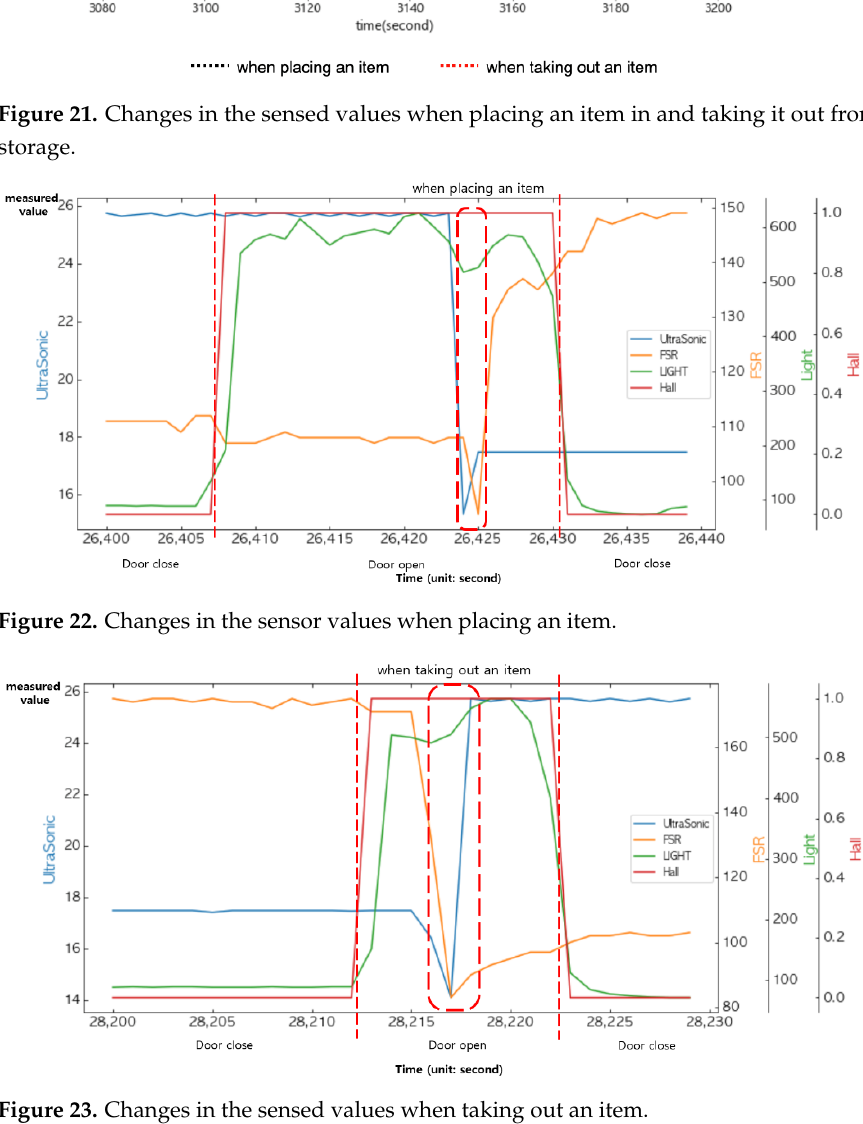
Figure 23. Changes in the sensed values when taking out an item.